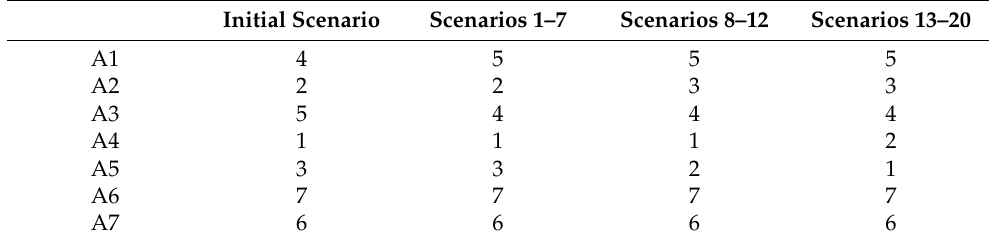
Table 12. Ranks of alternatives using different scenarios.